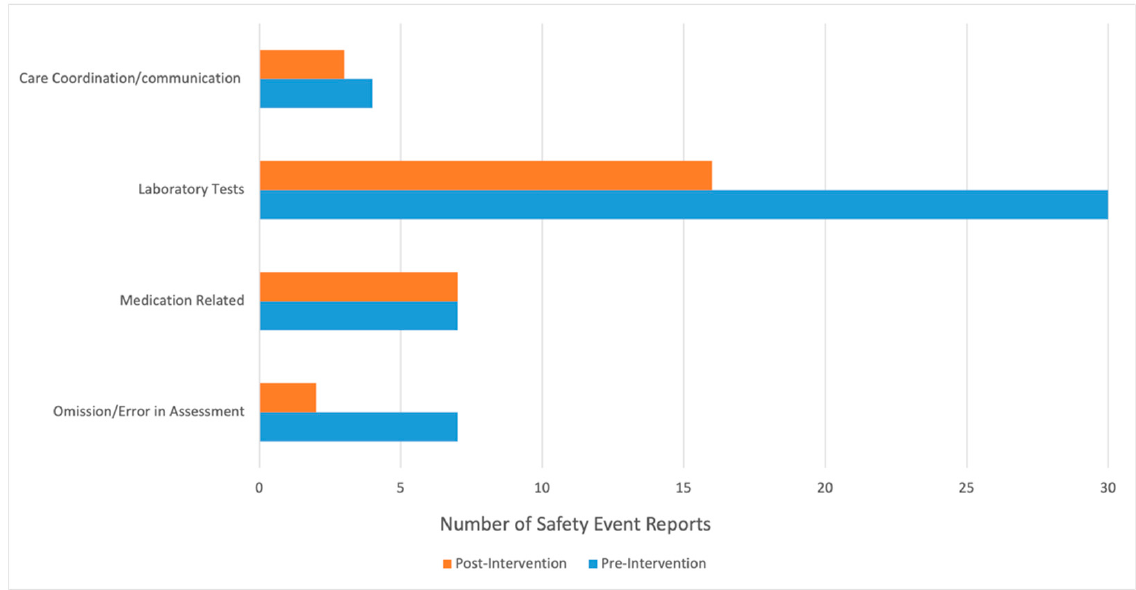
Figure 5. Safety Event Data. Safety event reports from the six-month period prior to implementation of our initiative (August 2019 to January 2020) and the six-month period following implementation of our initiative (March 2020–August 2020) were retrospectively reviewed to assess our initiative’s impact on safety events. y -axis demonstrates categories for the type of events reviewed. x -axis demonstrates the number of safety event reports for each category, with blue bars representing pre-intervention and orange bars representing post-intervention.